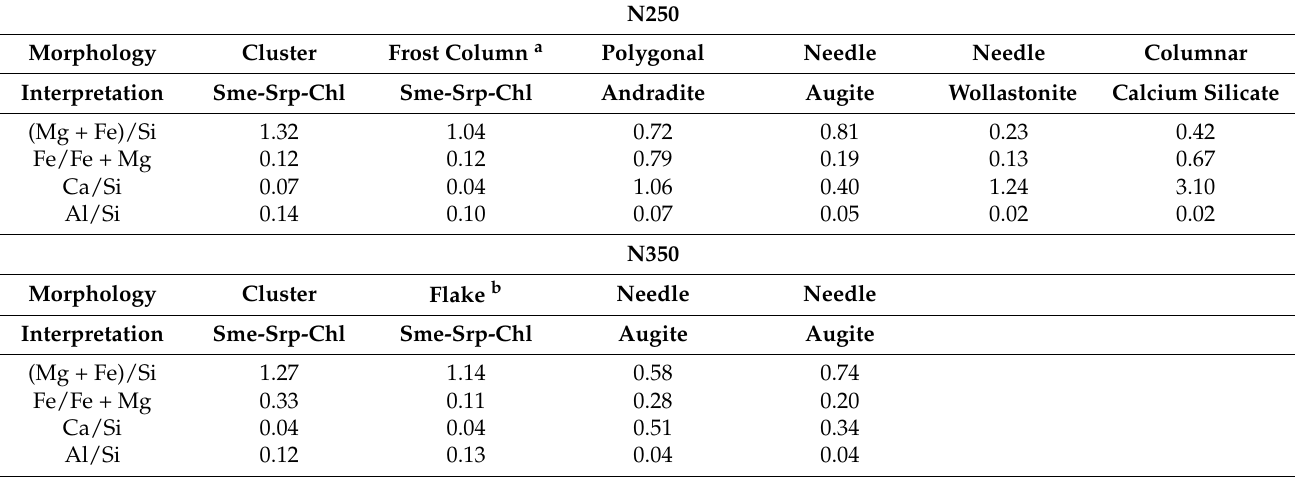
Table 5. Representative elemental compositions measured using SEM/EDS (atom number